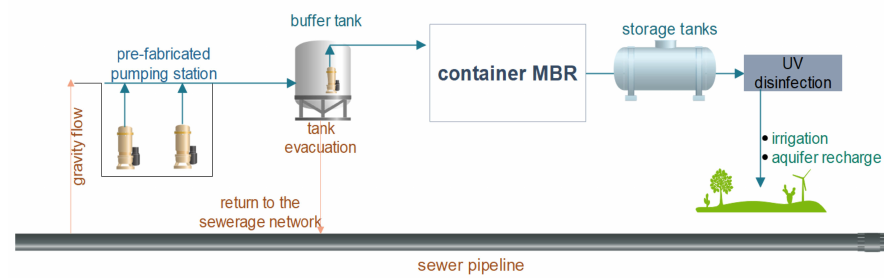
Figure 4. The Athens pilot configuration.